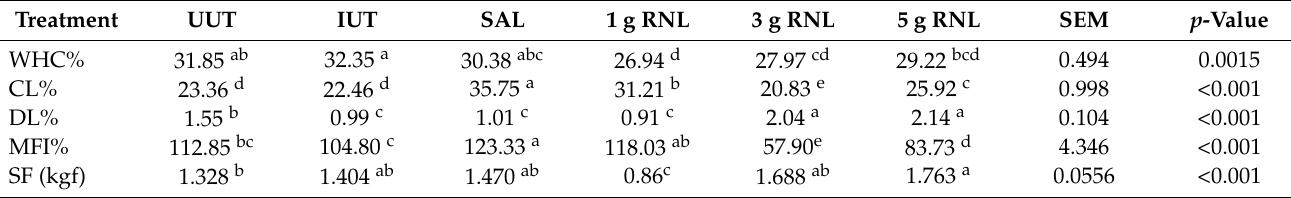
Table 5. Water-holding capacity (WHC), cooking loss (CL), dripping loss (DL), myofibril fragmentation index (MFI), and shearing force (SF) in the breast meat of broilers fed experimental diets supplemented with Rumex nervosus leaves.